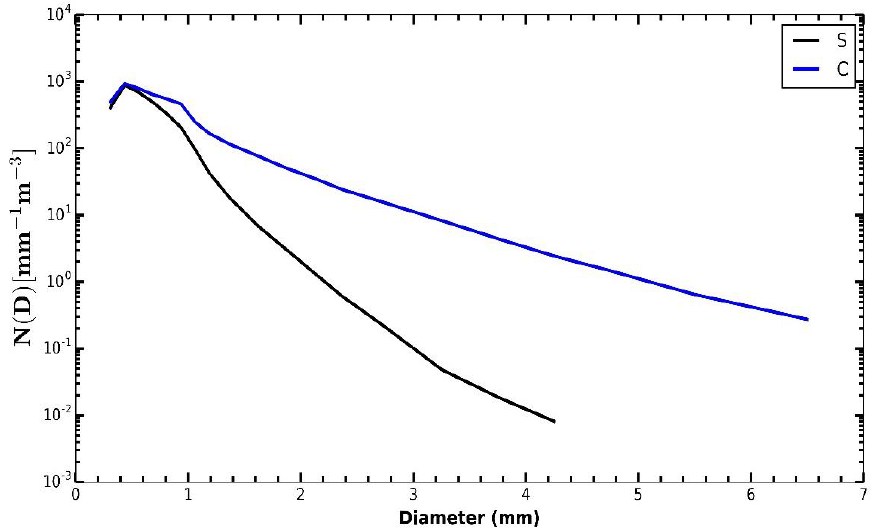
Figure 6. Average Spectra of the RSD for convective rainfall and stratiform rainfall for dataset (18 months) registered by the Parsivel2.